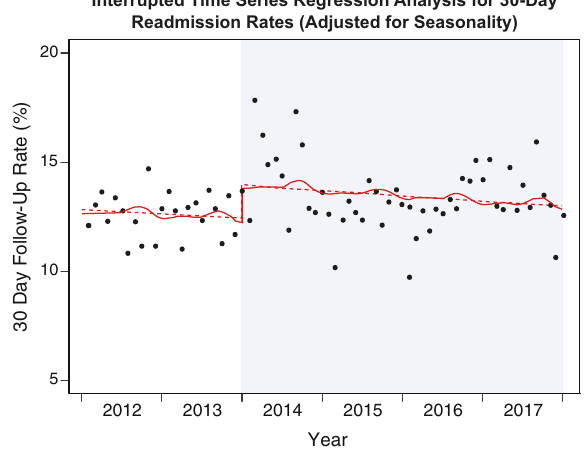
Fig. 4 Interrupted time series regression analysis for 30-day readmission rates (adjusted for seasonality). Interrupted time series of pre-order era and EMR-order era using monthly data based on Poisson regression model adjusted for seasonality. Solid line: predicted trend based on seasonally adjusted model. Dashed line: de-seasonalized